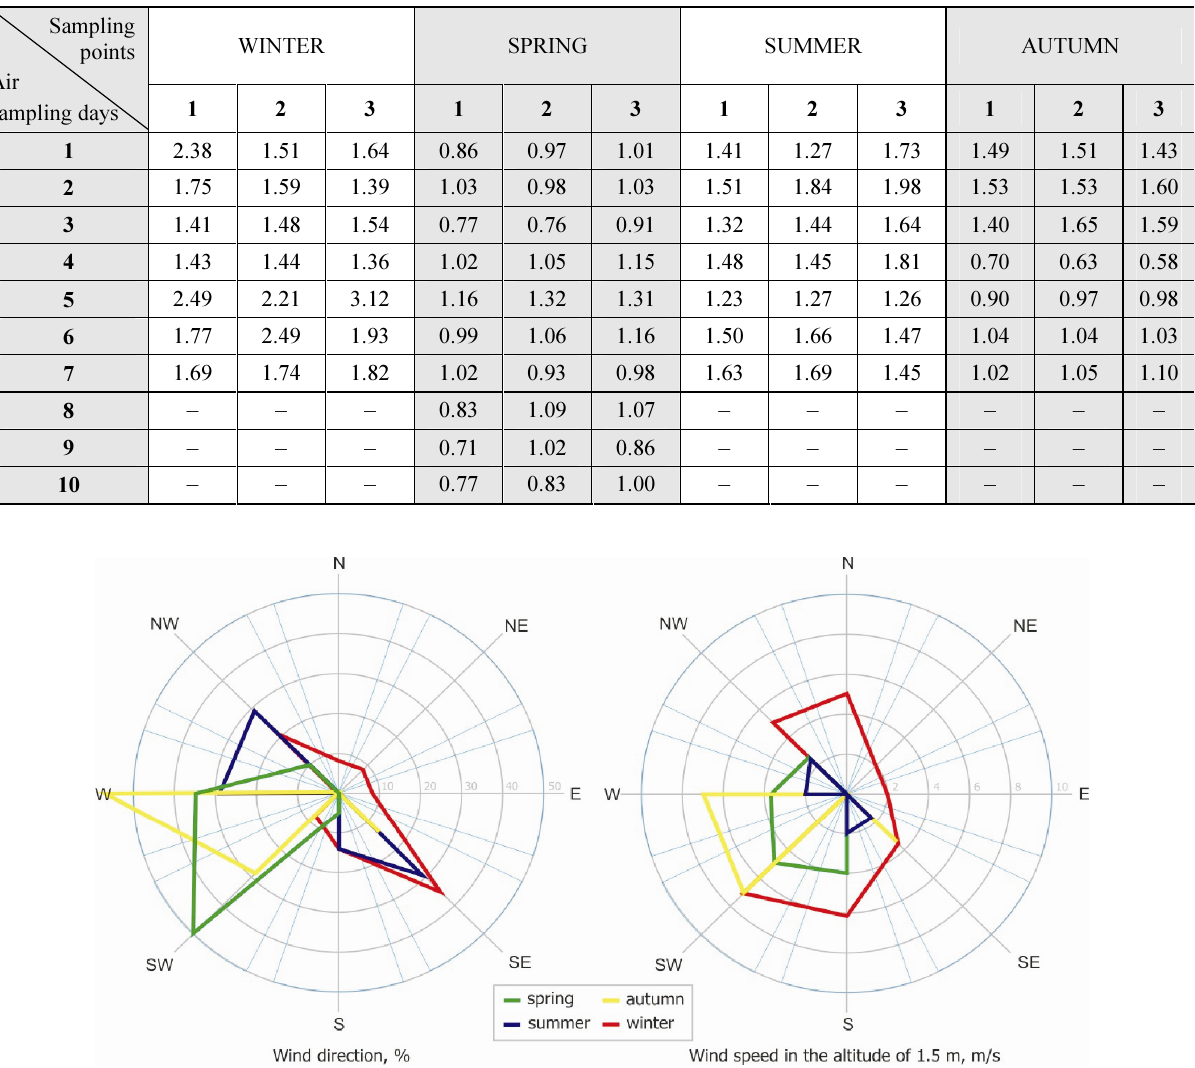
3 ) in observation posts during different seasons